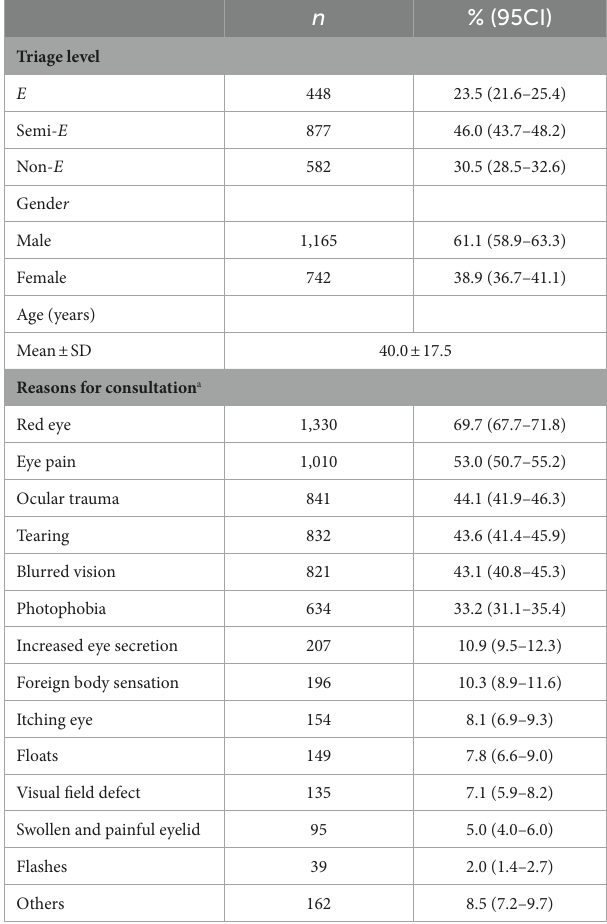
TABLE 1 Overall description of the study population.